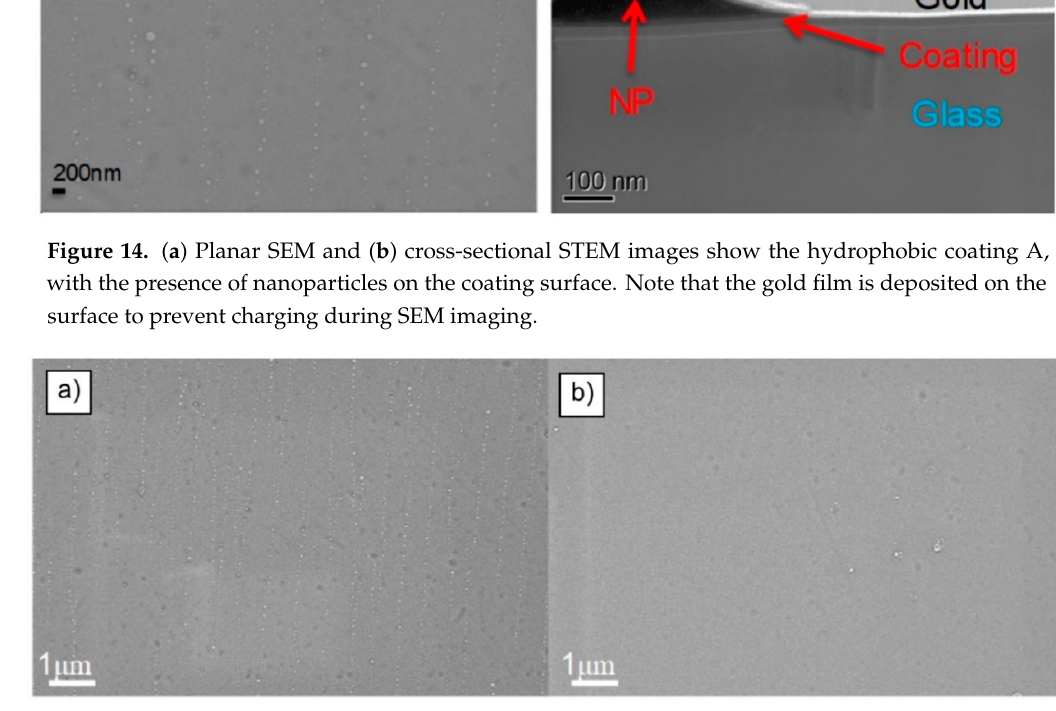
Figure 15. Planar view SEM images of the hydrophobic coating A, with nanoparticles ( a ) as-deposited and ( b ) after 500 h of UV exposure. The nanoparticles are no longer visible.